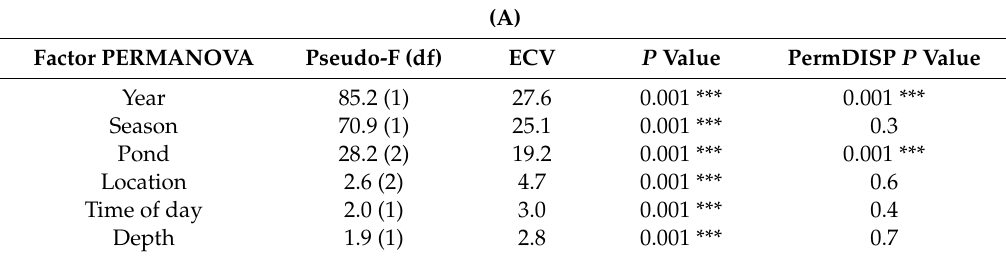
Table A3. A. PERMANOVA analysis testing the differences in the Bacteroidetes phylum between year (2012, 2013), season (early wet and dry), pond number (P1, P2 and P5), location within the ponds (inlet, middle and outlet), time of day (6 am and 1 pm) and depth of the water sampled (surface and benthic). The term “df” represents degrees of freedom, “ECV” square root of estimates of components of variation indicating the effect size as average% SV dissimilarity due to that factor (residual ECV 36.0). P value is based on > 9912 unique permutations; “PermDISP” permutational distance-based test for homogeneity of multivariate dispersions for main factors. *** P value = 0.001; ** P value < 0.01; * P value < 0.05. B. Similarity percentages (SIMPER) analysis identifying species contributions to the change between ponds 1 and 5 for Bacteroidetes indicator families: Chitinophagaceae , Porphyromonadaceae , Cytophagaceae and Cryomorphaceae . Average dissimilarity between ponds 1 and 5 = 79.5%. Bray-Curtis similarity cut off =